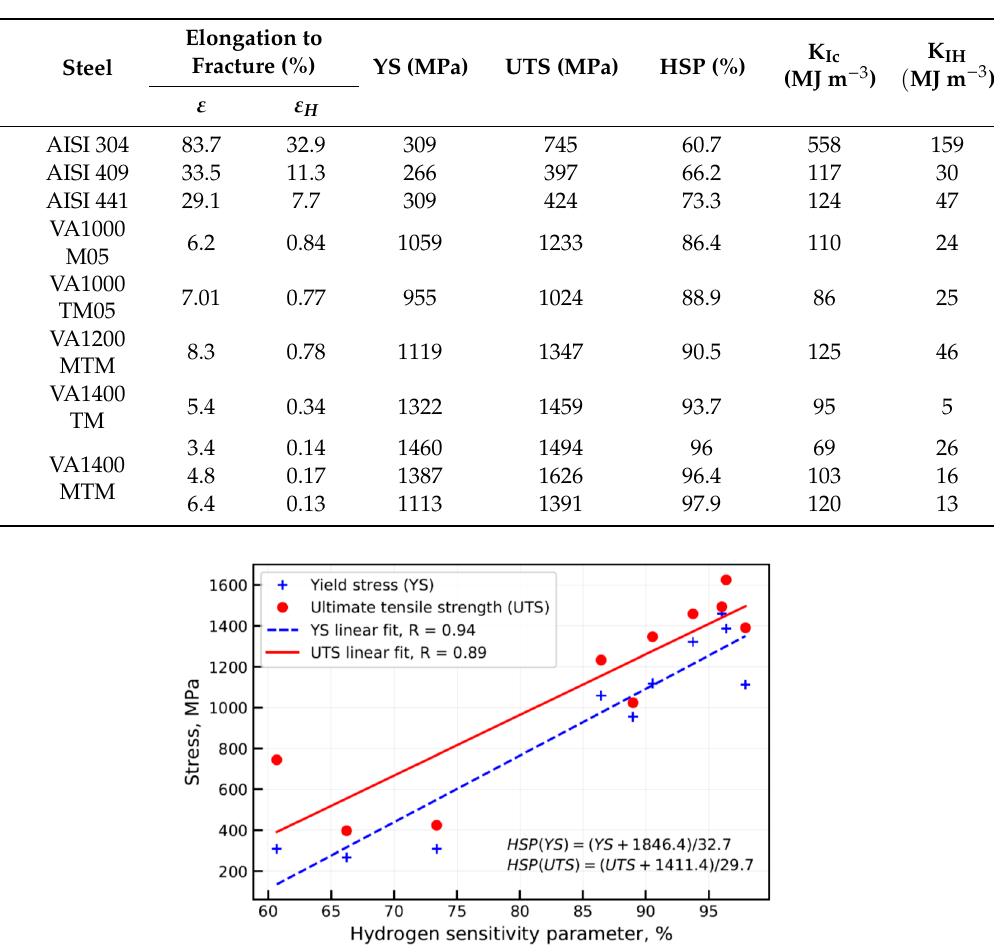
Figure 4. Relationship between yield stress (YS) and ultimate tensile strength (UTS) vs. hydrogen sensitivity parameter (HSP) measured experimentally.